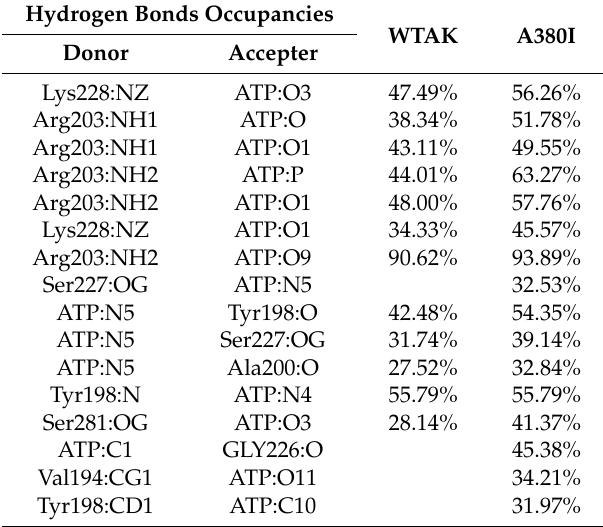
Figure 5. RMSD analysis of two complexes. ( A ) RMSD from residues Val120–Gly170. ( B ) The probability of RMSD from residues Val120–Gly170. ( C ) RMSD from residues Leu220–Glu270. ( D ) The probability of RMSD from residues Leu220–Glu270. Table 2. Hydrogen bond occupancy between ATP and CpAK during 100 ns MD.